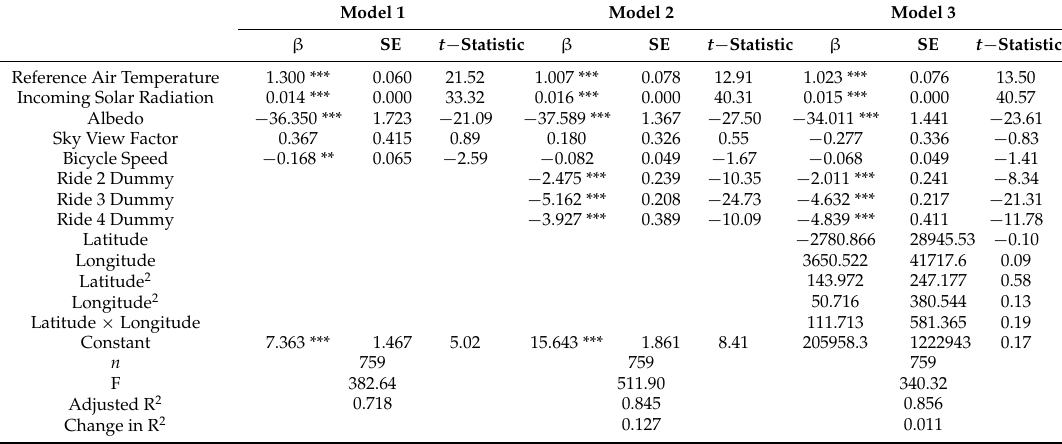
Table 3. Regression analysis for ground surface temperatures on the canal